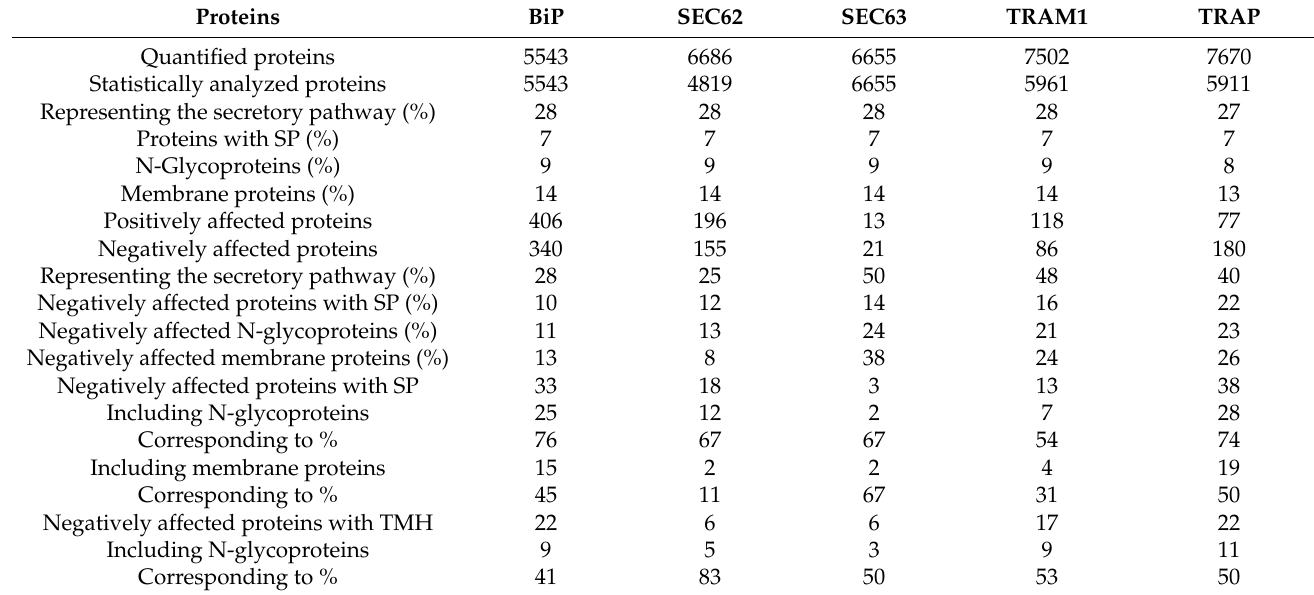
Table 3. Statistics for the identification of BiP, Sec62, Sec63, TRAM1, and TRAP clients in HeLa